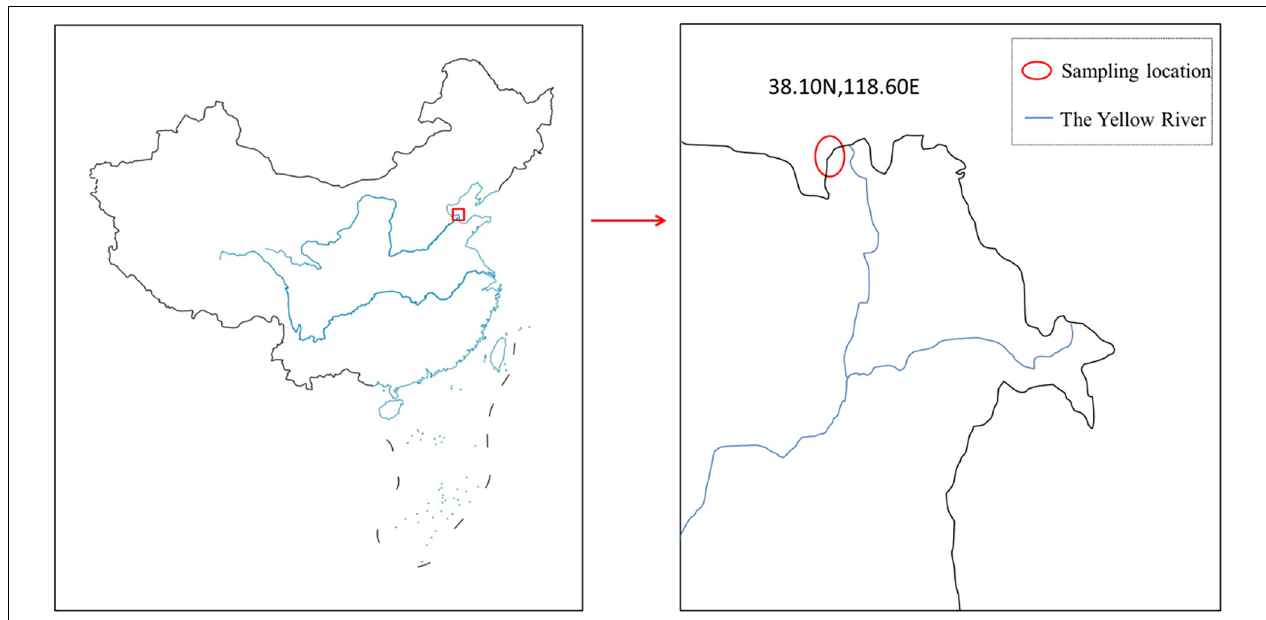
FIGURE 2 | Location of the sample collection site in Yellow River Delta of